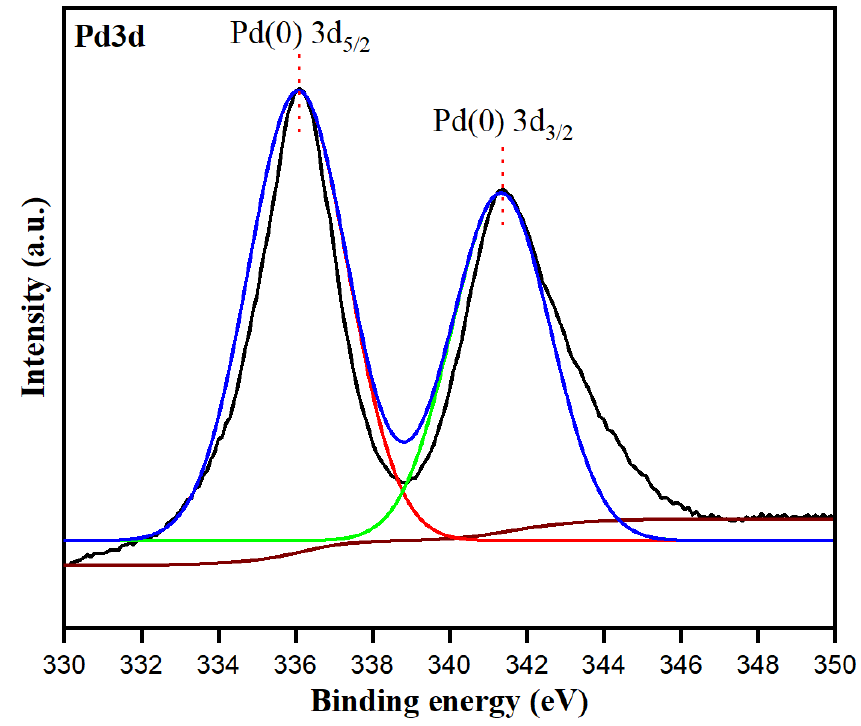
Figure 7. XPS spectrum showing the binding energy of Pd